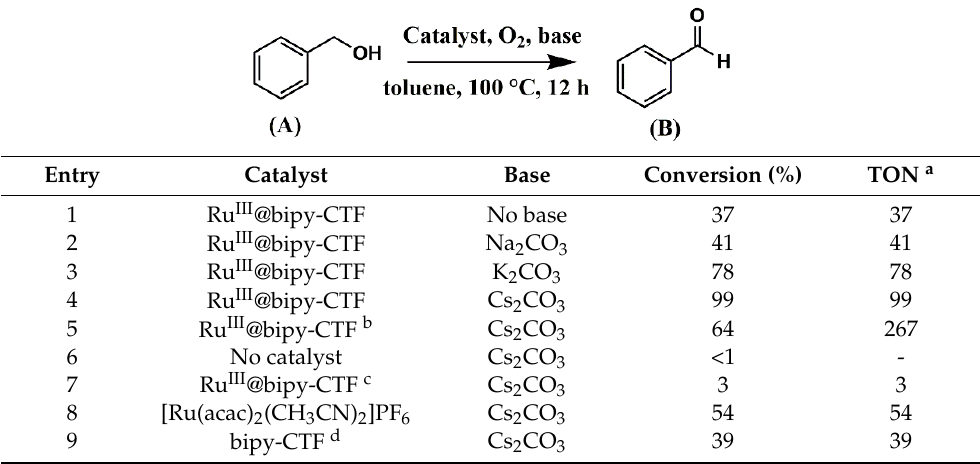
Reaction conditions: 1 mol% catalyst (based on Ru, obtained from ICP-OES analysis), 0.33 mmol benzyl alcohol, 0.4 mmol